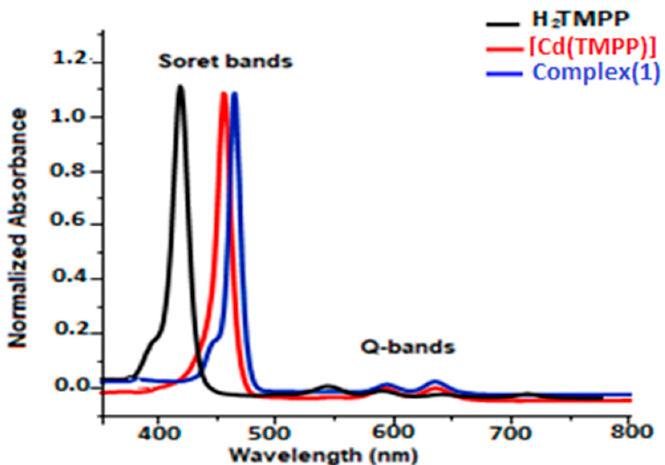
Figure 10. UV-Vis absorption spectra of H 2 TMPP, [Cd(TMPP)], and [Cd(TMPP)(Pyz)] ( 1 ) (CH 2 Cl 2 , c = 10 − 5 M, 298 K). c = 10 − 5 M, 298